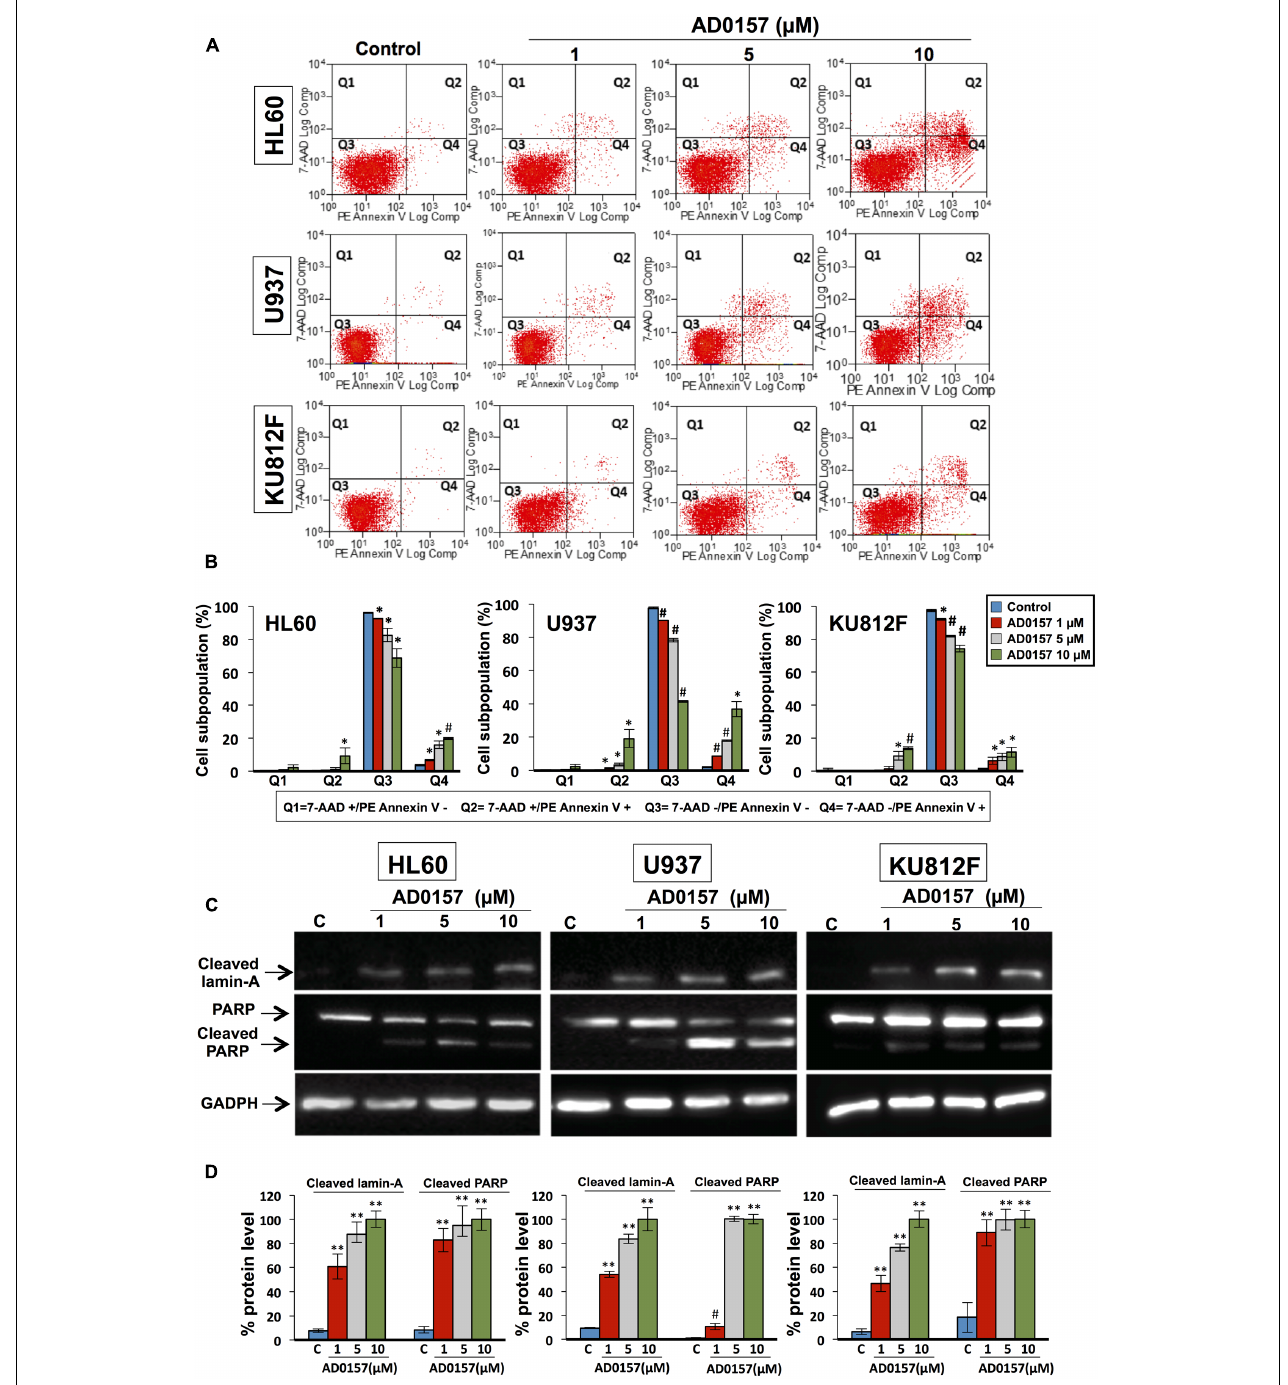
FIGURE 4 | AD0157 causes early and late apoptosis and cleavage of lamin-A and PARP in human myeloid leukemia cells. (A) Representative examples of flow cytometry dot blots for untreated and AD0157-treated leukemia cells. Q1: 7AAD+/PE-Annexin V − (necrotic cells), Q2: 7AAD+/PE-Annexin V+ (late apoptotic cells), Q3: 7AAD -/PE-Annexin V- (viable cells) and Q4: 7AAD-/PE-Annexin V+ (early apoptotic cells). HL60, U937 and KU812F cells were incubated with AD0157 at the indicated concentrations for 14 h and assessed by 7AAD/PE-Annexin V stainings and flow cytometry studies. (B) Quantification of the different populations (necrotic, late and early apoptotic and viable leukemic cells). Values are expressed as means ± SD of three independent experiments. ∗ p < 0.05 and # p < 0.005 versus control. (C) Western blots of cleaved lamin-A, PARP and cleaved PARP in HL60, U937 and KU812F control cells and treated for 14 h with the indicated concentrations of AD0157. (D) Quantification by densitometry of Western blot bands. Results are expressed as the average relative protein level percentage ± SD of three independent experiments. The percentage obtained with the higher dose of compound is considered the 100%. # p < 0.005 and ∗∗ p < 0.001 versus